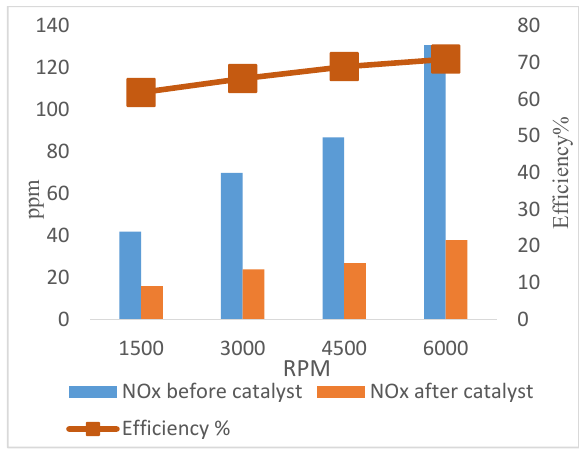
Figure 6. Conversion of NO X with Co 3 O 4 /TiO 2 .